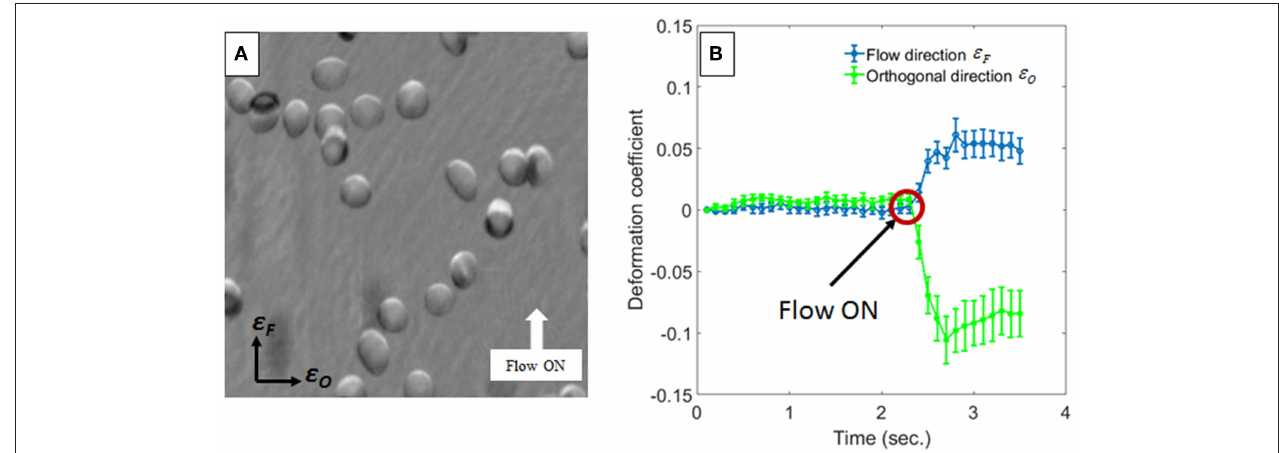
FIGURE 3 | Measurements of RBCs deformation. In (A) the phase difference between two images taken before and after the hydrodynamic stress is reported. In (B) the average deformation coefficients with the corresponding standard deviations (i.e., the error bars), along orthogonal to the flow direction, calculated for all RBCs in (A) , are shown. The red circle highlights the instant of time in which the pump pressure starts to work.